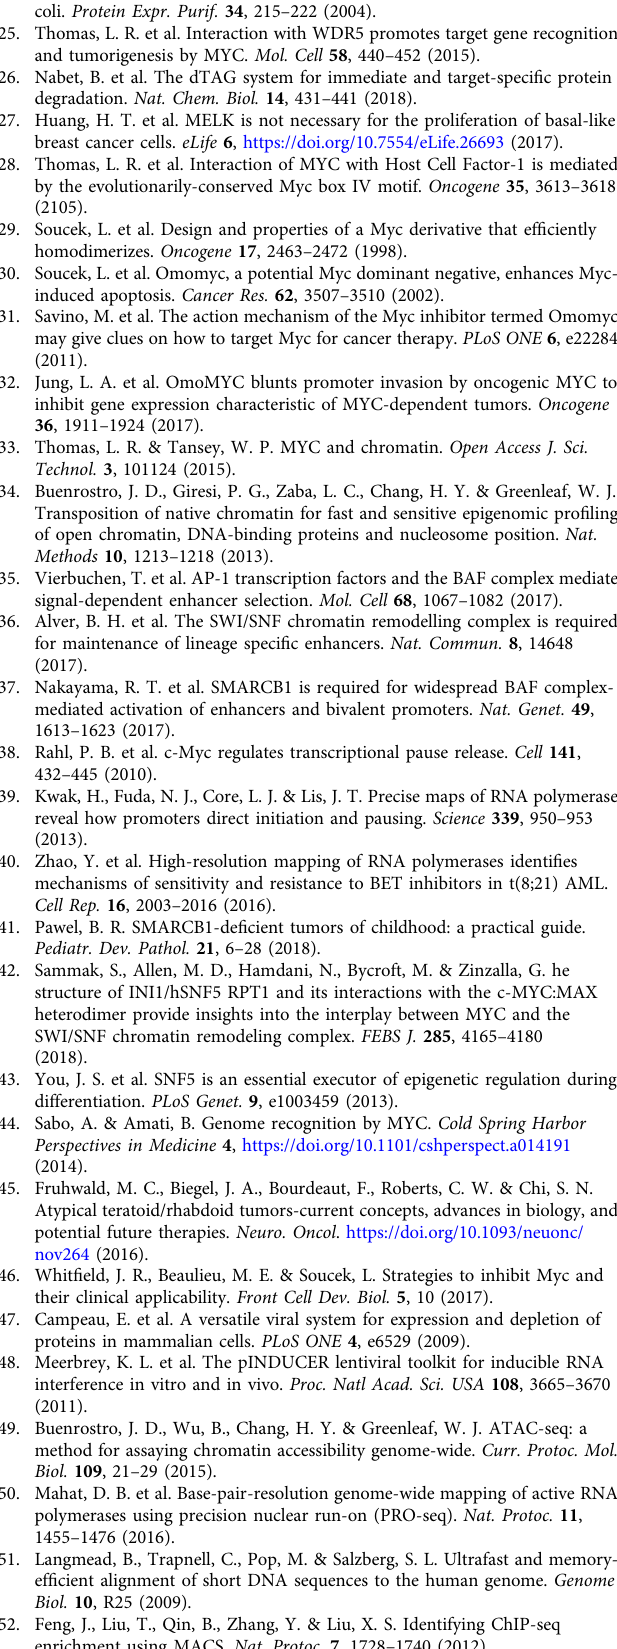
Table 2. Any other data supporting the fi ndings in this study are available upon request. Uncropped scans for all blots are presented in Supplementary Fig.